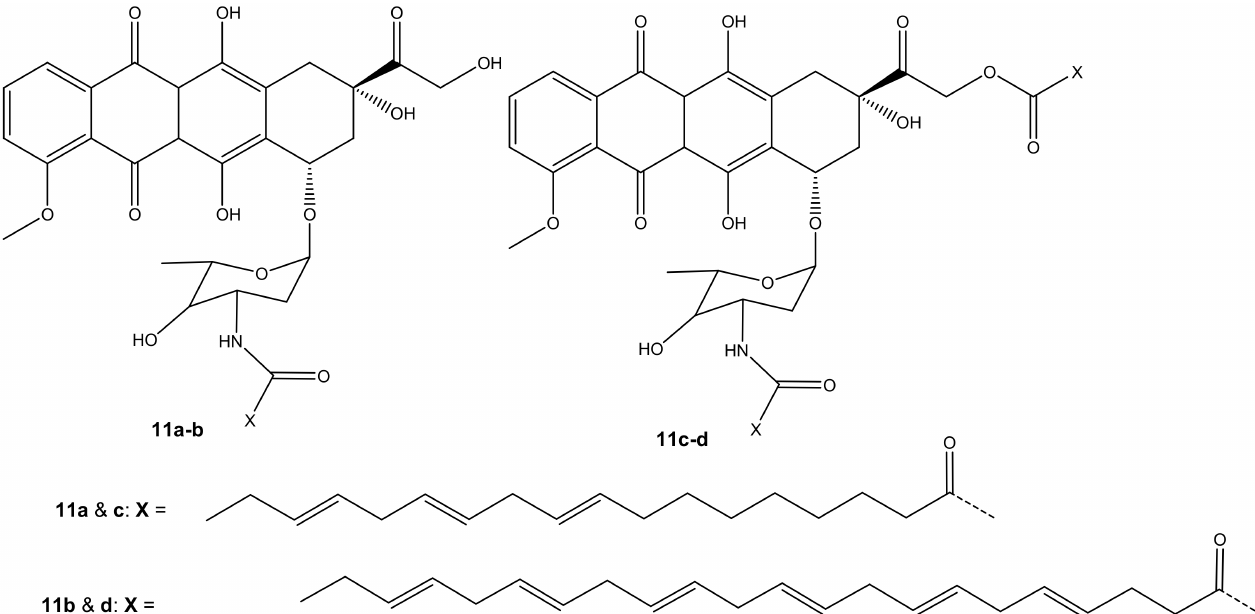
Figure 7. Chemical structures of doxorubicin conjugated with DHA and α -LA conjugated through amidation and esterification ( 11a – d ).